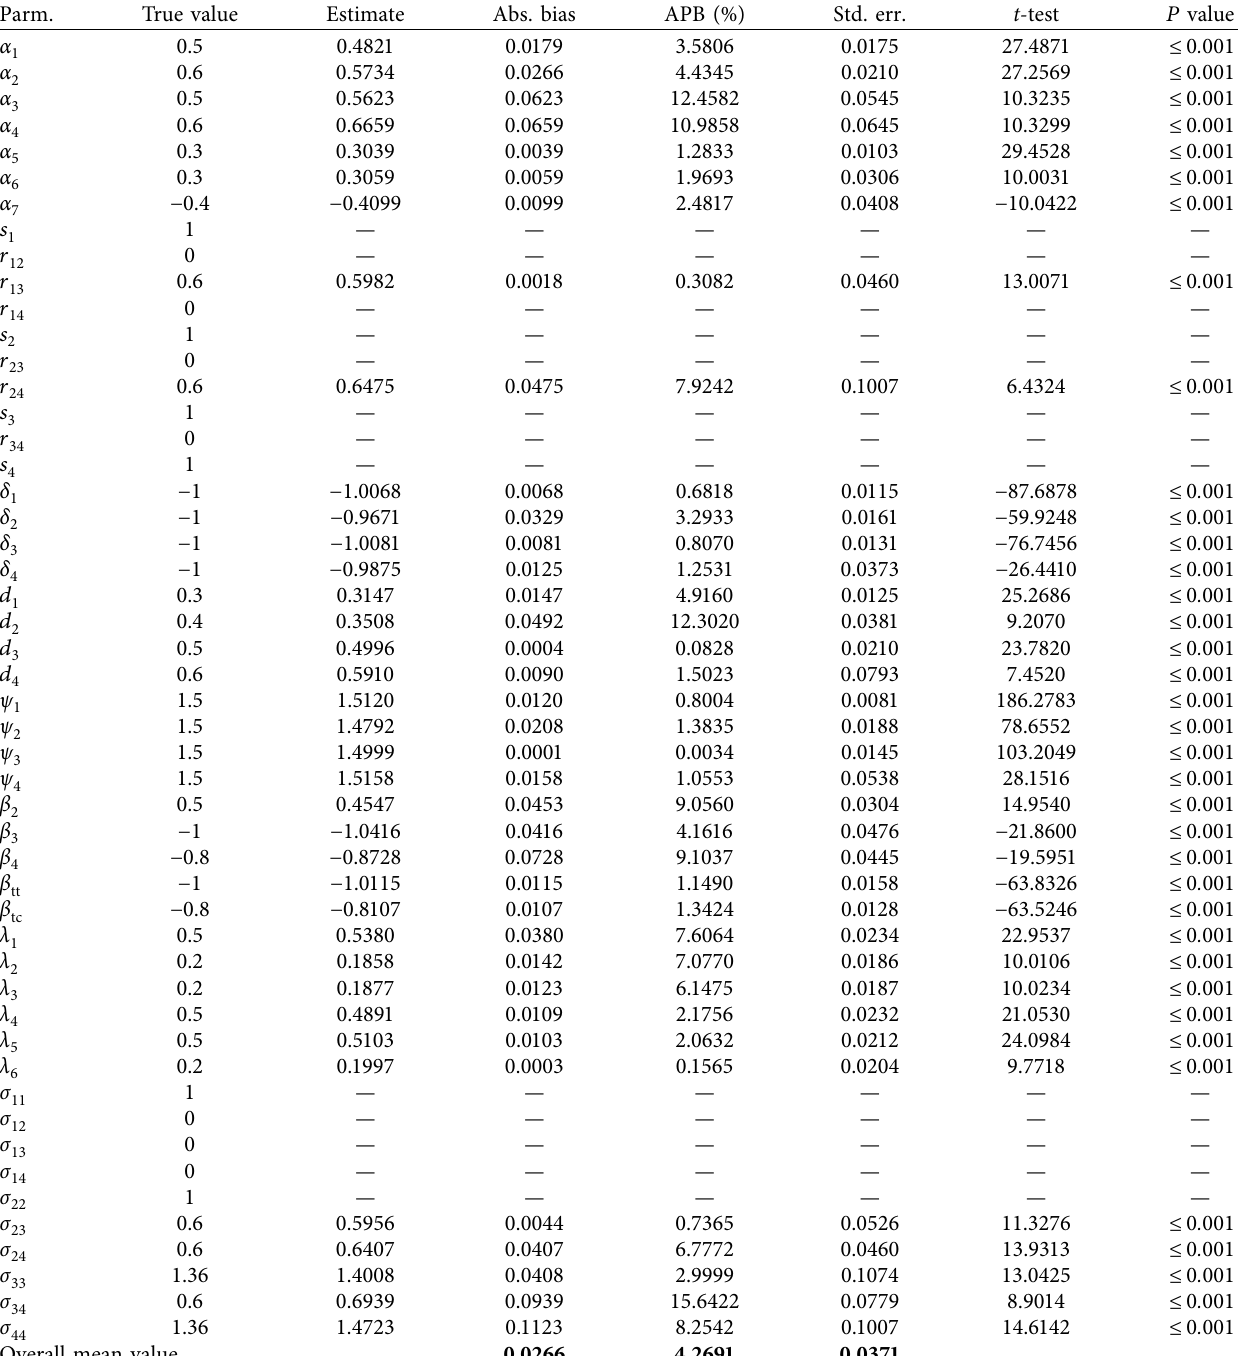
Table 4: Simulation results for the four-alternative ICLV model with the ME method.